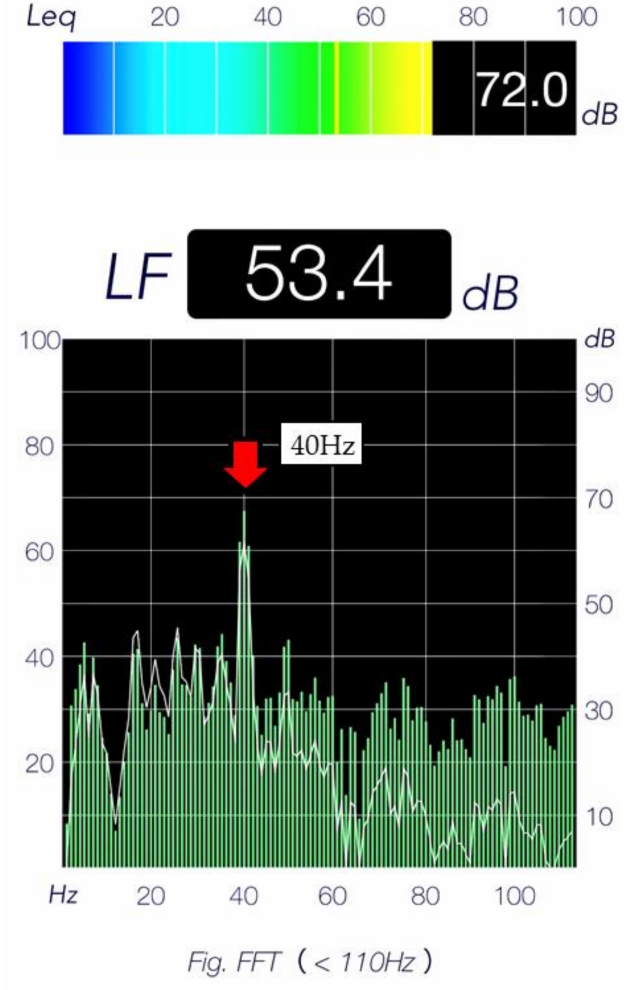
Figure 1. Acoustic analysis software to perform acoustic analysis.